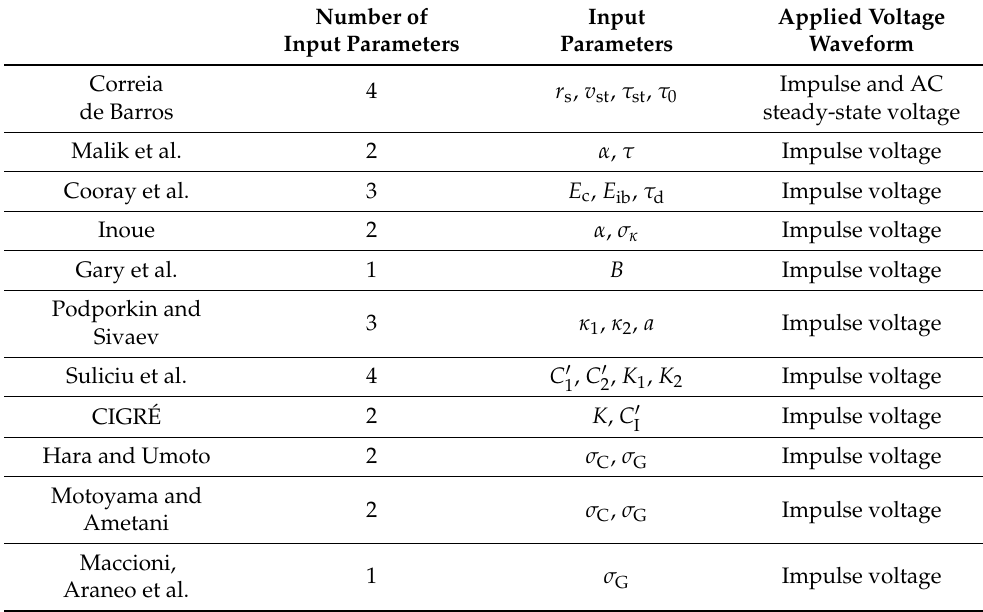
Table 5. Comparison of the models.